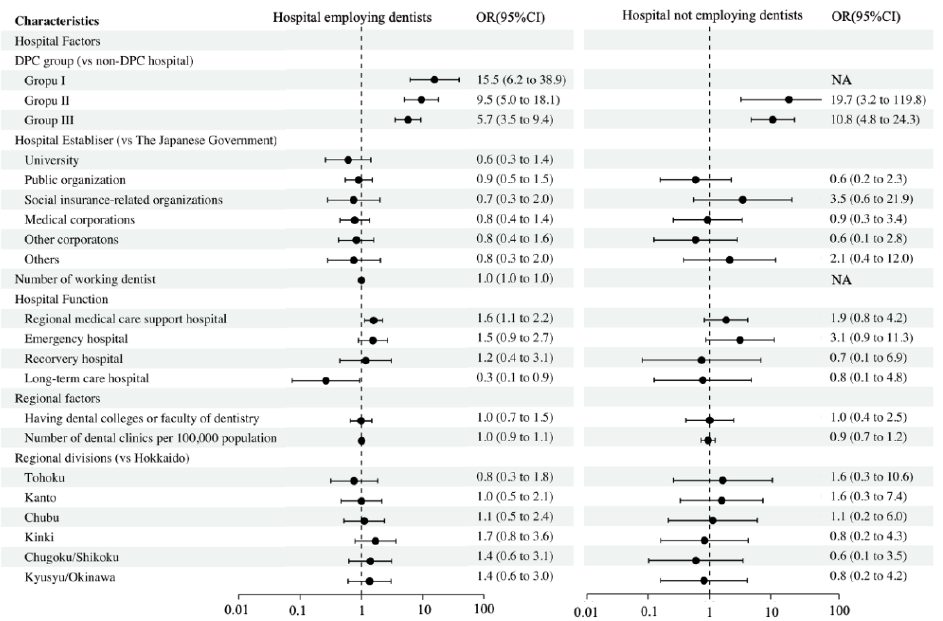
Figure 2. Factors associated with hospitals employing dentists. Abbreviations: OR, odds ratio; 95% CI, 95% confidence interval.